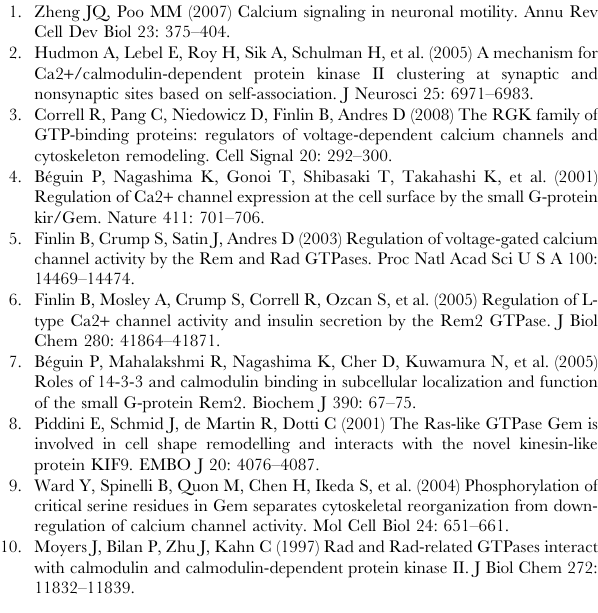
Figure S1 Rem2 redistribution is independent of epi- tope tag. ( A ) Confocal images of GFP-Rem2 (top) and HA-Rem2 (center) and their overlay (bottom) after stimulation of a neuronal culture. Neurons were stimulated for 60 seconds with 100 m M glutamate/10 m M glycine, recovered for 5 minutes then fixed in 4% paraformaldehyde. Cells were then probed with rat anti-HA antibody followed by anti-rat secondary conjugated to Alexa-594. ( B ) Intensity Correlation Analysis of the overlap between Alexa- 594 and GFP signals in glutamate/glycine-stimulated cells transfected with HA-Rem2 + GFP or HA-Rem2 + GFP-Rem2. Puncta formed by GFP-Rem2 overlapped those formed by HA- Rem2 (ICQ for HA-Rem2 + GFP alone, 0.085 6 0.007, N= 5; HA- Rem2 + GFP-Rem2, 0.283 6 0.026, N= 8; t-test p =0.0001), indicating that the Rem2 foci were consistently formed upon stimulation, regardless of the molecular tag. Figure S2 CaMKII and Rem2 clusters in dendrites and cell body. Data represented in Figure 6C are broken down here by cellular compartment. The upper panels show the mean clustering factor of CaMKII and Rem2 in the presence and absence of CaMKIIN in dendrites, while the lower panels show clustering in the cell body. Note that Rem2 clustering in the dendrites persists, while clusters in the cell body begin to dissipate after about 5 minutes. Figure S3 CaMKII drives Rem2 aggregation in HEK cells. ( A ) HEK cells transfected with Rem2, CaMKII or both show no aggregation under basal conditions (upper panels). In response to a pH drop/ionomycin protocol, CaMKII forms robust aggregates, while Rem2 does not (lower panels). Rem2 can aggregate upon stimulation in the presence of CaMKII. ( B ) CaMKIIIIN inhibits CaMKII aggregation upon stimulation (left panel set), while Rem2 is unchanged by CaMKIIIIN (right panel set). Coexpression of these three plasmids results in lowered CaMKII-Rem2 co-aggregation (bottom panel set). Scale bar represents 10 m m.